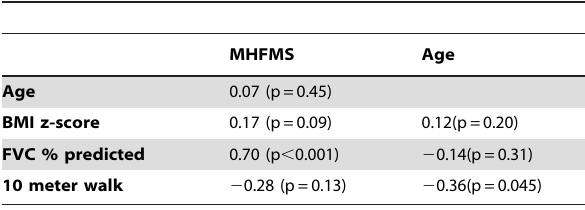
Table 2. Correlations of secondary measures with MHFMS and age for SMA